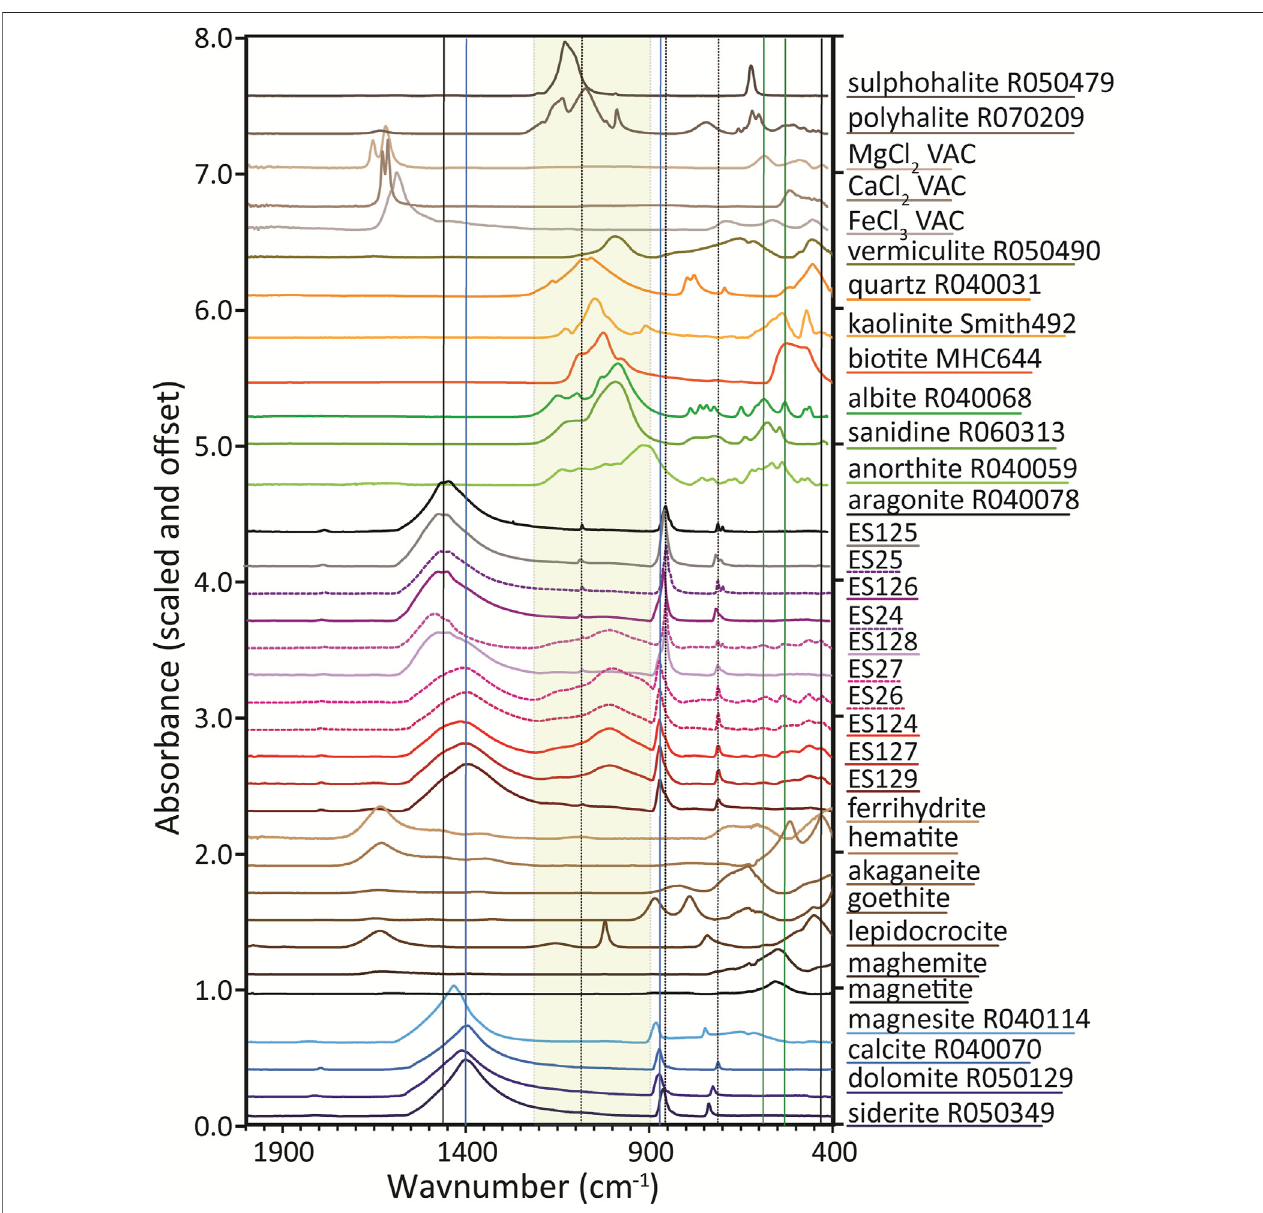
FIGURE 4 | FTIR ATR spectra of Blood Falls samples along with FTIR spectra of representative identi fi ed, possible trace phases, and several conjectured phases. Note that FTIR reference spectra for several phases considered do not exist, are of insuf fi cient quality, or were taken using a different experimental con fi guration (diffuse re fl ectance) and are therefore not directly comparable to our samples. Spectra for nanophase iron (oxyhydr)oxides are from Sklute et al., 2018b. All R* labeled samples arefromtheRRUFFspectraldatabase(Lafuenteetal.,2015).The “ VAC ” samplesarefromSkluteetal.,2018a).MHCandSmithsamplesarefromMtHolyokeand Smith Colleges ’ private